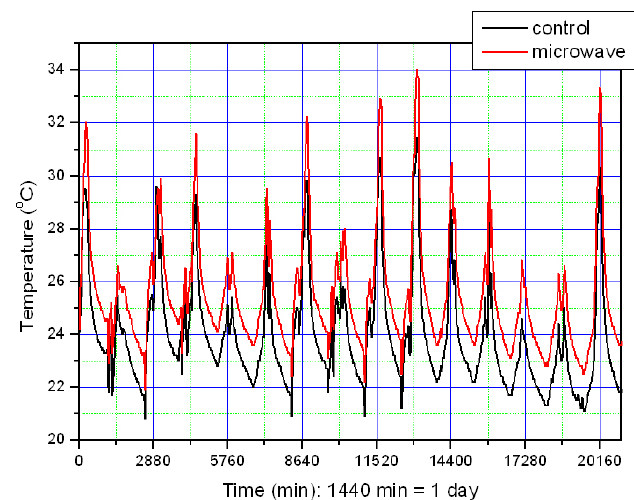
Figure 1. Temperature variation depending on the time in both chambers.